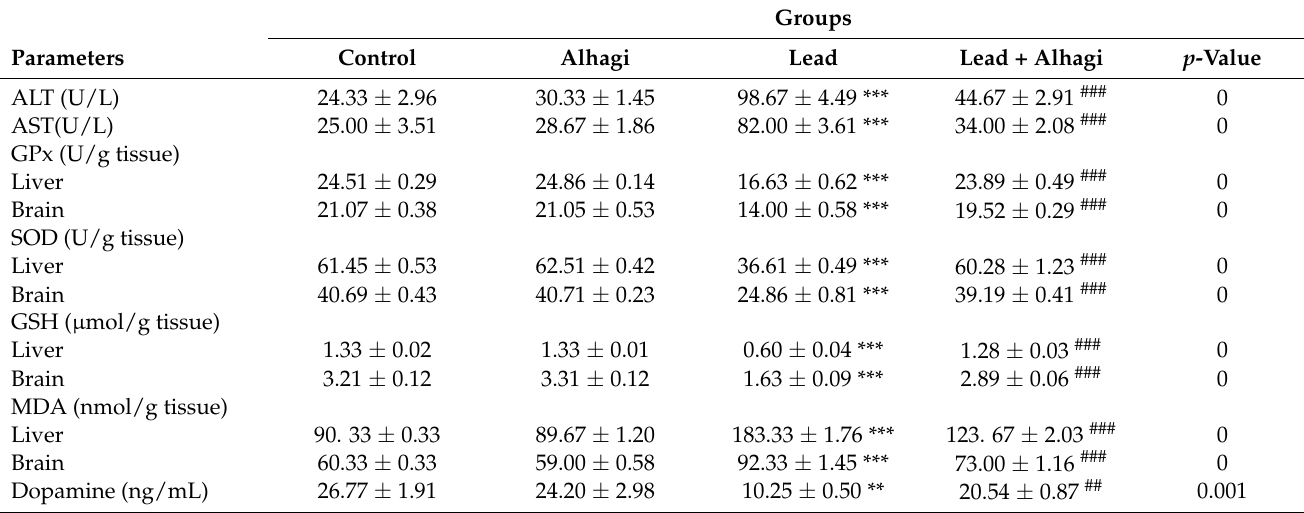
Table 4. Effect of the A. maurorum extract (300 mg/kg BW, orally) on liver function markers (ALT and AST), brain dopamine level, and antioxidant enzyme activities (GPx and SOD), GSH, and MDA levels in the hepatic and brain tissues of rats treated with lead (100 mg/kg BW, orally) daily for 3